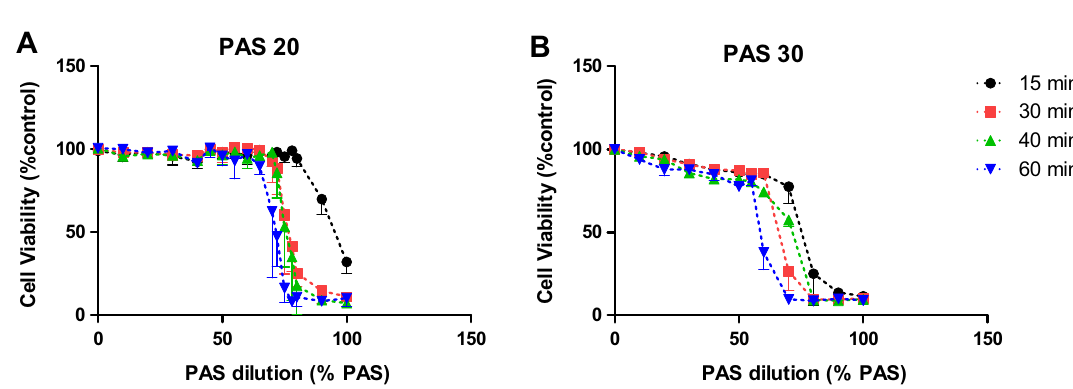
Figure 5. Cell viability of HaCaT cells treated with different dilutions of PAS 20 (A) and PAS 30 (B) at 15 min, 30 min, 40 min and 60 min contact